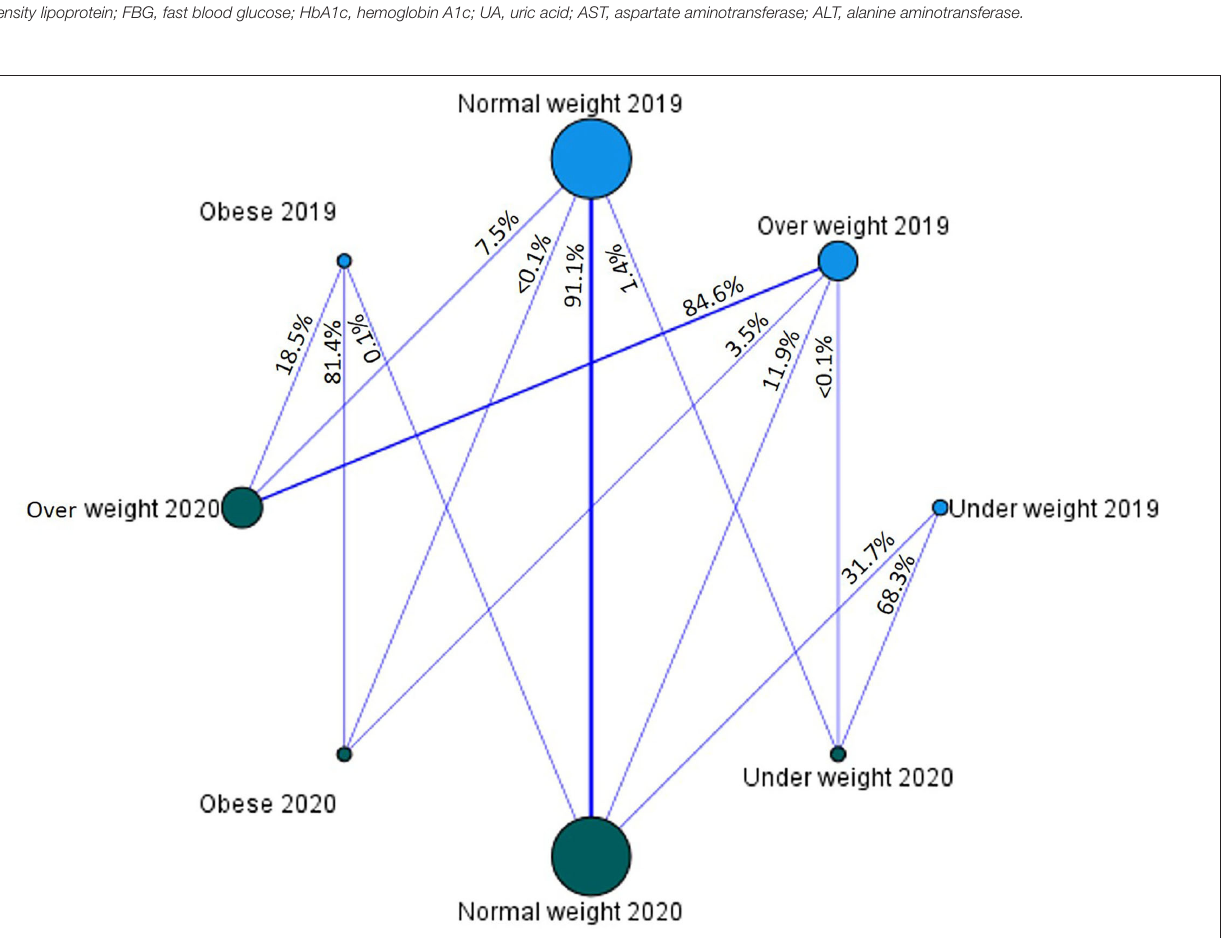
Frontiers in Public Health |